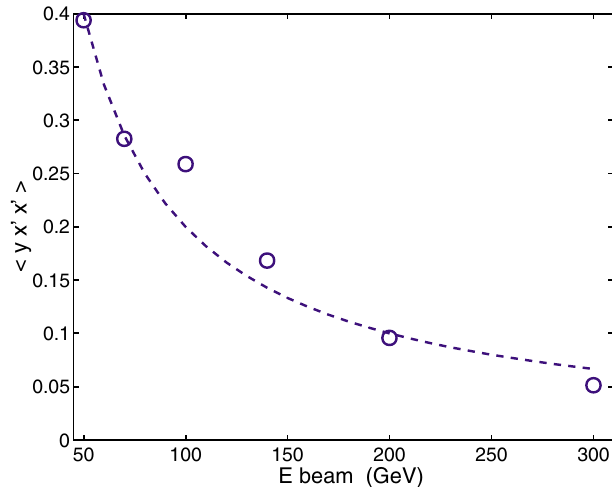
FIG. 20. (Color) One of the remaining second order terms at the IP, h yx 0 x 0 i , for the SiD model with an antisolenoid corrected only with linear